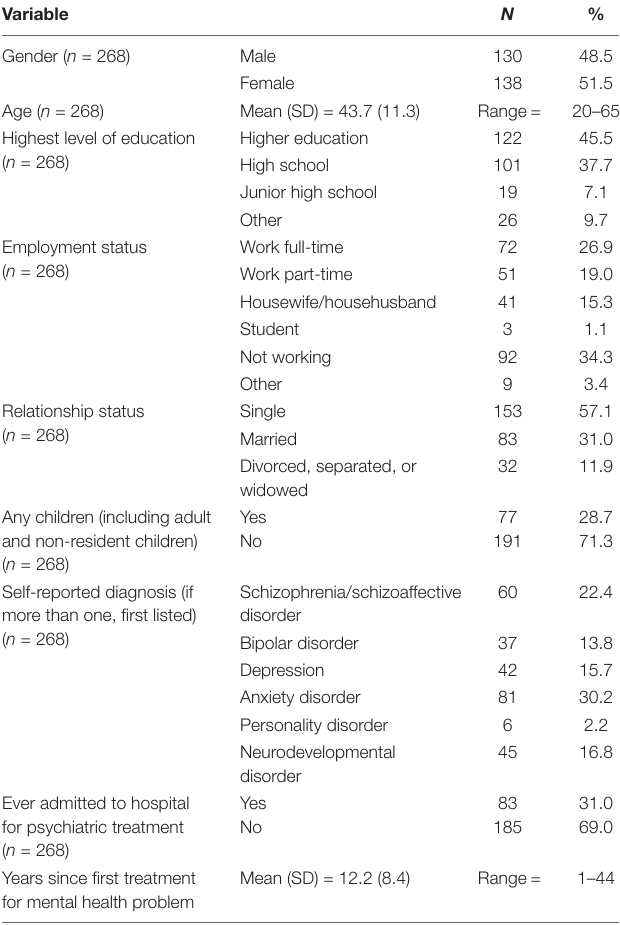
TABLE 1 | Participant sociodemographic and clinical